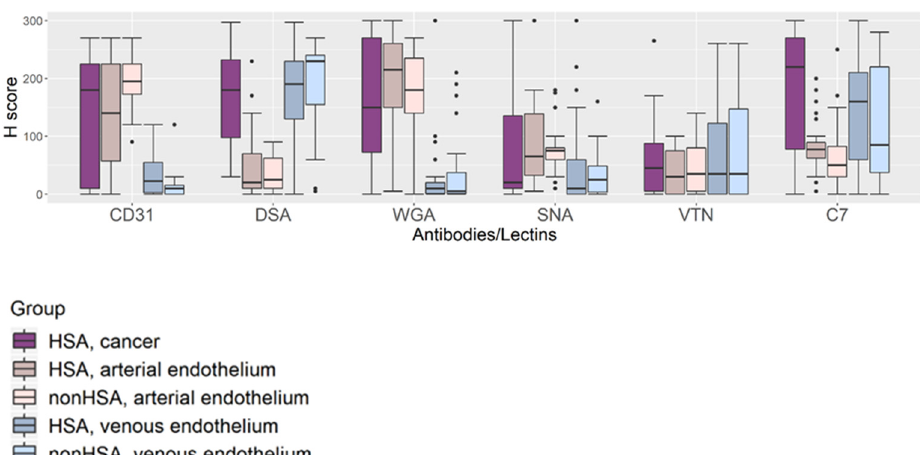
Figure 3. Boxplot representing overall lectin-histochemistry (DSA, WGA, SNA) and immunohistochemical (CD31, VTN, C7) signal intensities. Three tissue components—HSA/cancer, arterial endothelium, and venous endothelium—were assessed in two sample groups—dogs with HSA and dogs without HSA. Differences in the level of tissue glycoprotein expression between tissue components and between HSA and non-HSA were